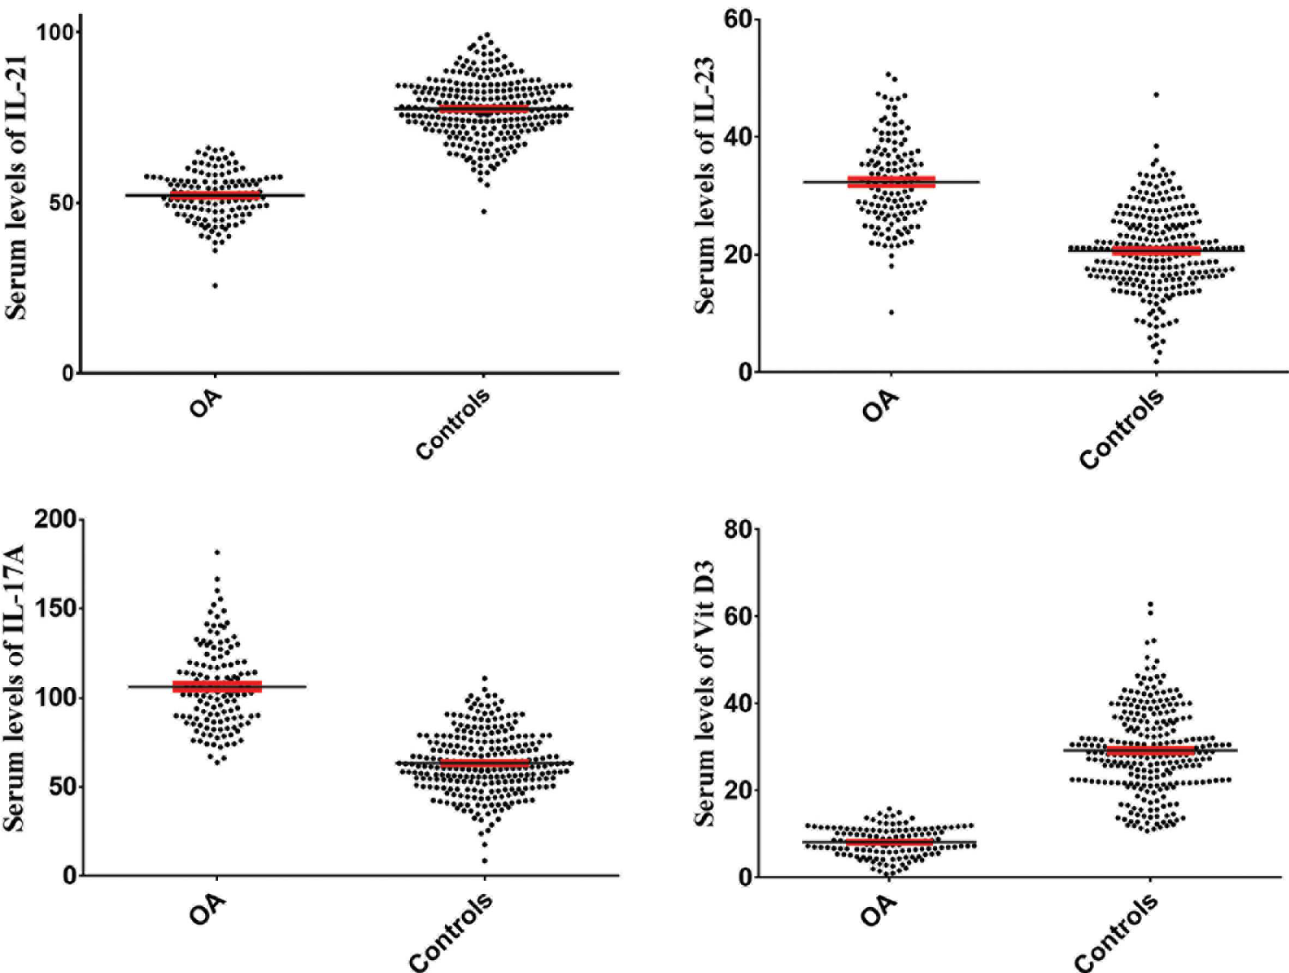
Fig 1. Serum levels of IL-21, IL-23, IL-17A and vitamin D3 in OA patients in comparison to healthy controls. Statistical analysis revealedthat serum levels of IL-23 and IL-17A were significantly increased, while, IL-21 and vitamin D3 were decreasedin OA patients in comparison to healthy controls.